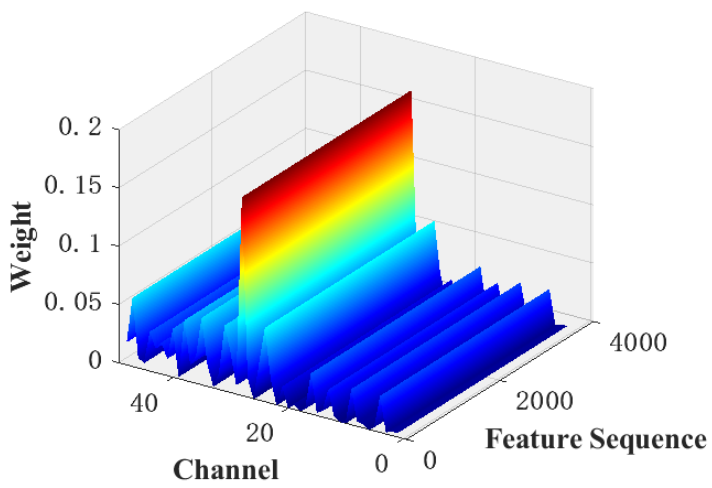
Figure 12. Weight of every channel of AdaSE (Abnormal).